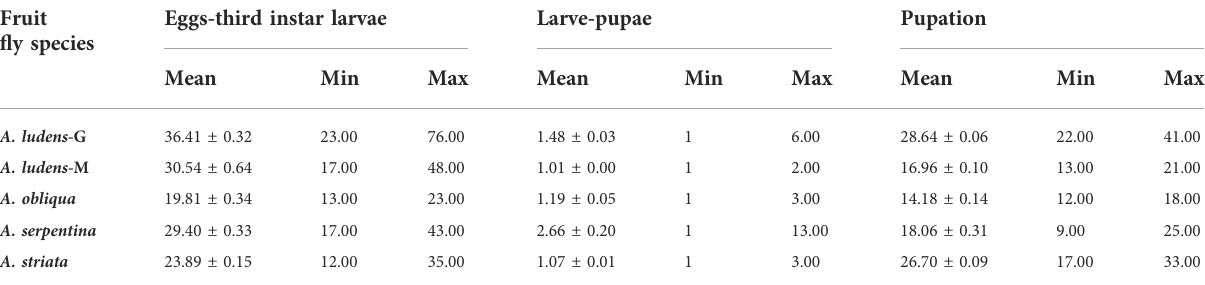
TABLE4Mean(±SE),minimumandmaximumvaluesfordevelopmenttimes(indays)ofimmaturestagesoffour Anastrepha speciesrearedunder fi eld conditions A. ludens -G (from grapefruit) and A. ludens -M (from mango). Fruit fl y species